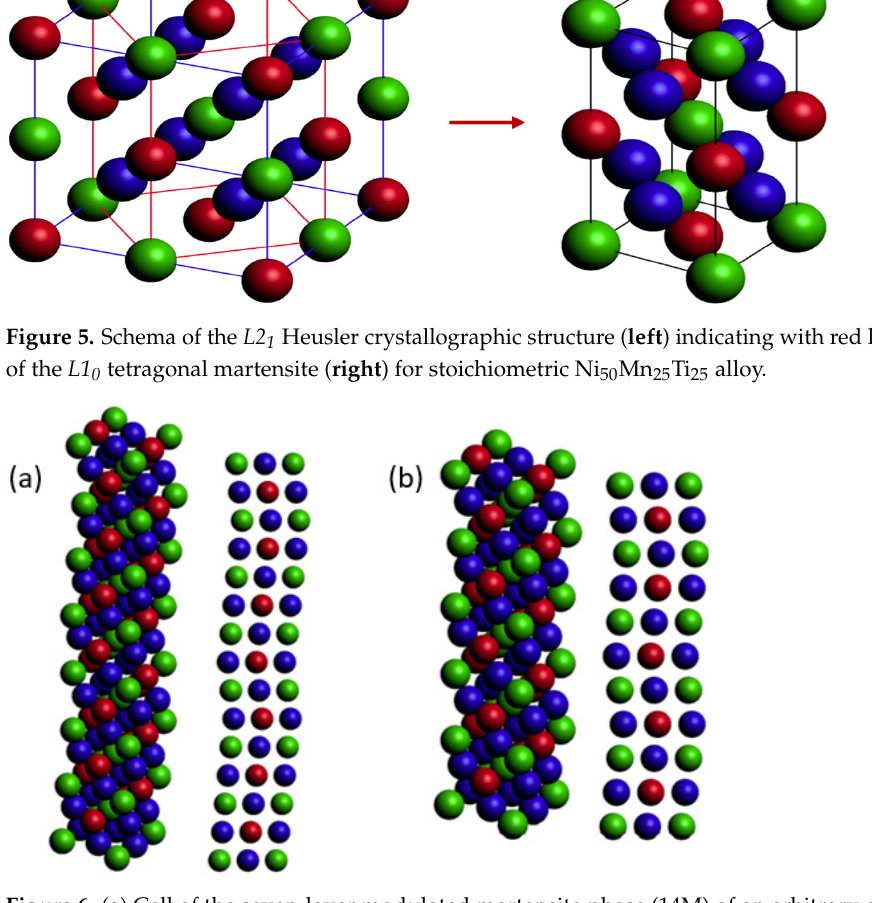
Figure 6. ( a ) Cell of the seven ‐ layer modulated martensite phase (14M) of an arbitrary composition sample seen in 3D and laterally. ( b ) Cell of the five-layer modulated martensite phase (10M) of an sample seen in 3D and laterally. ( b ) Cell of the five ‐ layer modulated martensite phase (10M) of an arbitrary composition sample seen in 3D and laterally (generated with MAUD-free software, version arbitrary composition sample seen in 3D and laterally (generated with MAUD ‐ free software, ver ‐ 2.08, Luca Lutterotti, Trento, sion 2.08, Luca Lutterotti, Trento, Italy).